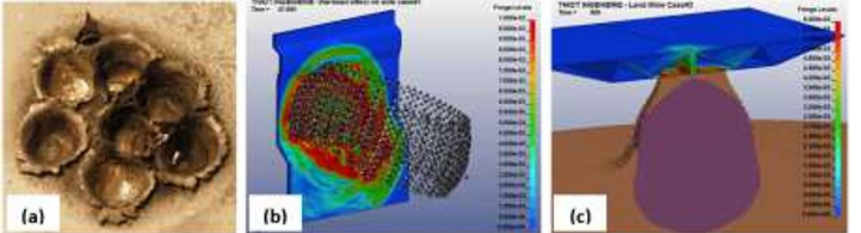
Fig. 2. Synchronized impact of seven steel fragments (a) ; Warhead fragments impact on a tactical vehicle side panel (b) and underbelly buried charge explosion determination